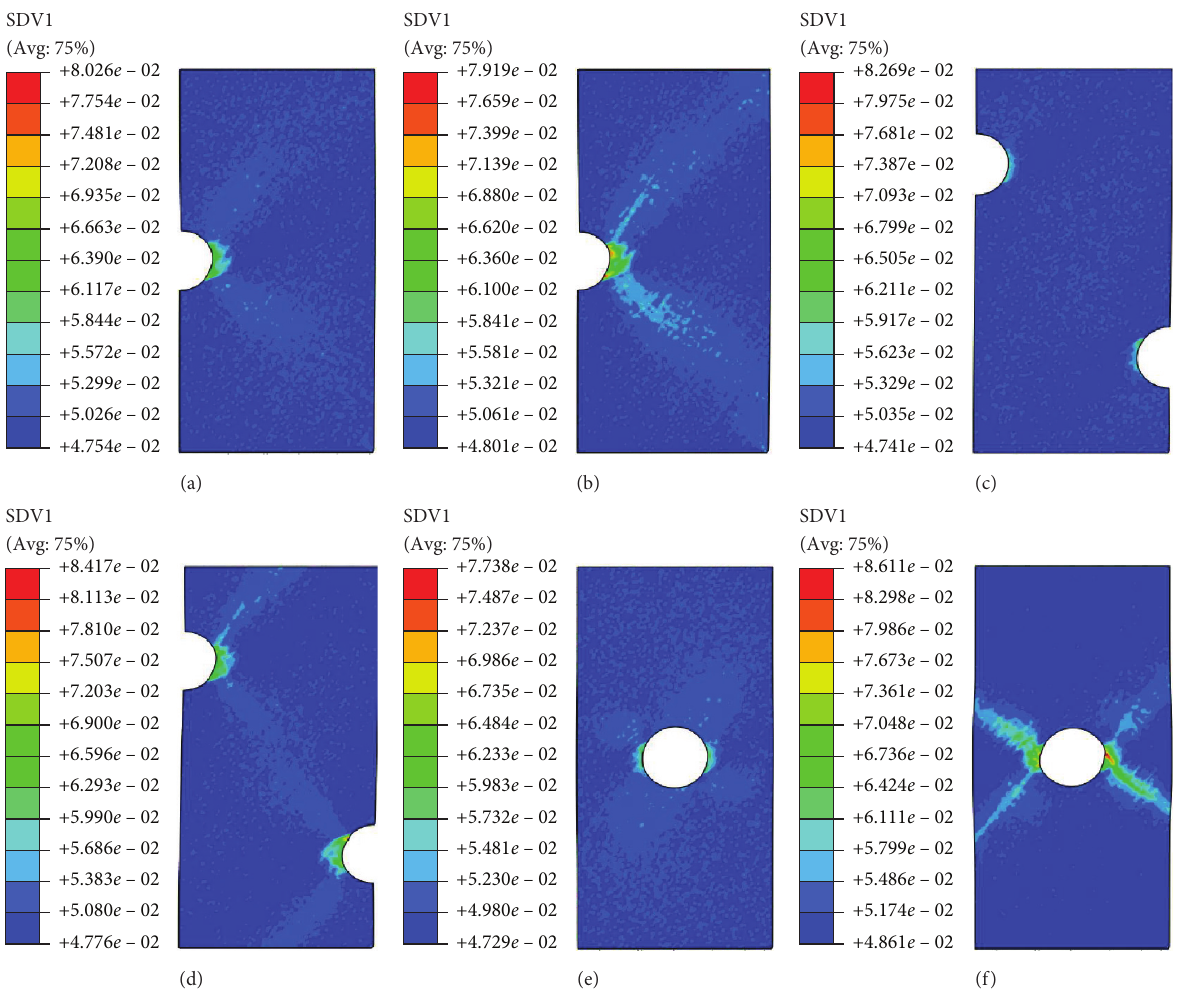
Figure 6: Contour plots of free-volume evolution for specimens A–C under different compressive strain levels. (a) Specimen A ε � 2.02%. (b) Specimen A ε � 2.38%. (c) Specimen B ε � 1.47%. (d) Specimen B ε � 2.05%. (e) Specimen C ε � 1.56%. (f) Specimen C ε �